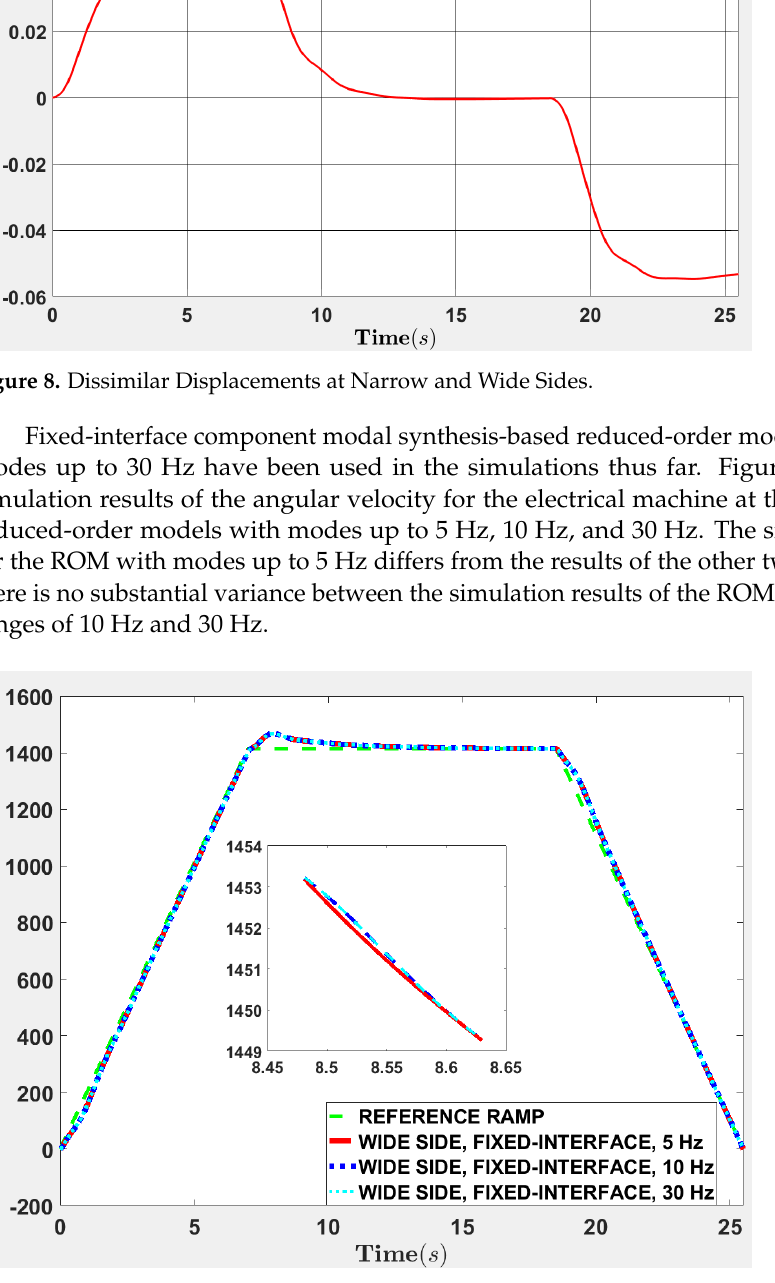
Figure 9. Wide Side Electrical Machine Angular Velocity for Fixed-Interface ROMs with Vary- ing